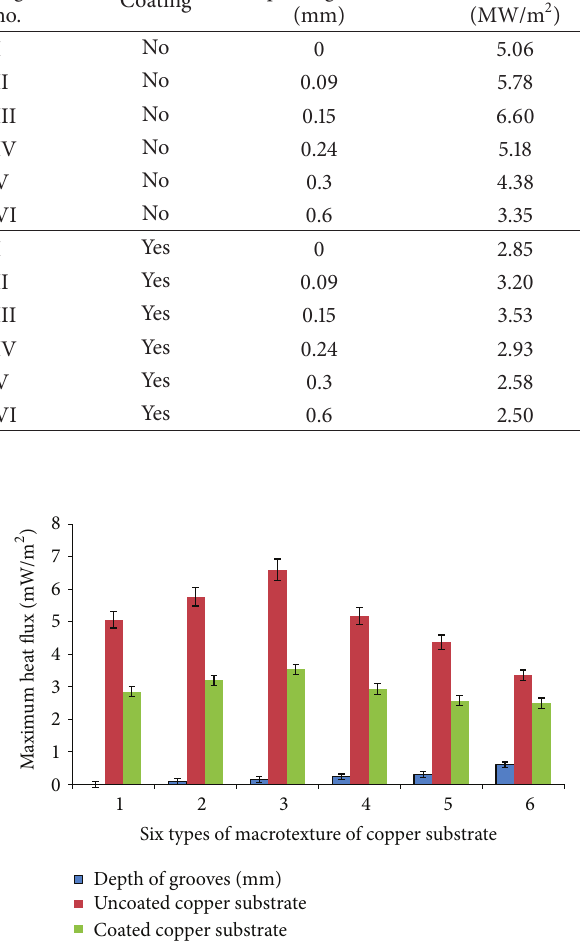
Figure 4: Effect of surface topology of substrate on heat flux with and without